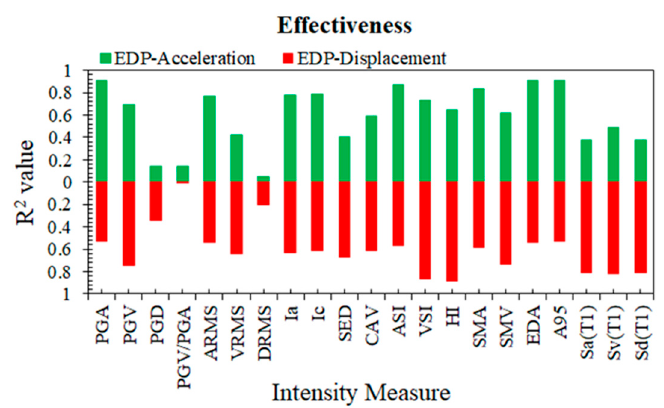
Figure 12. Effectiveness comparison.